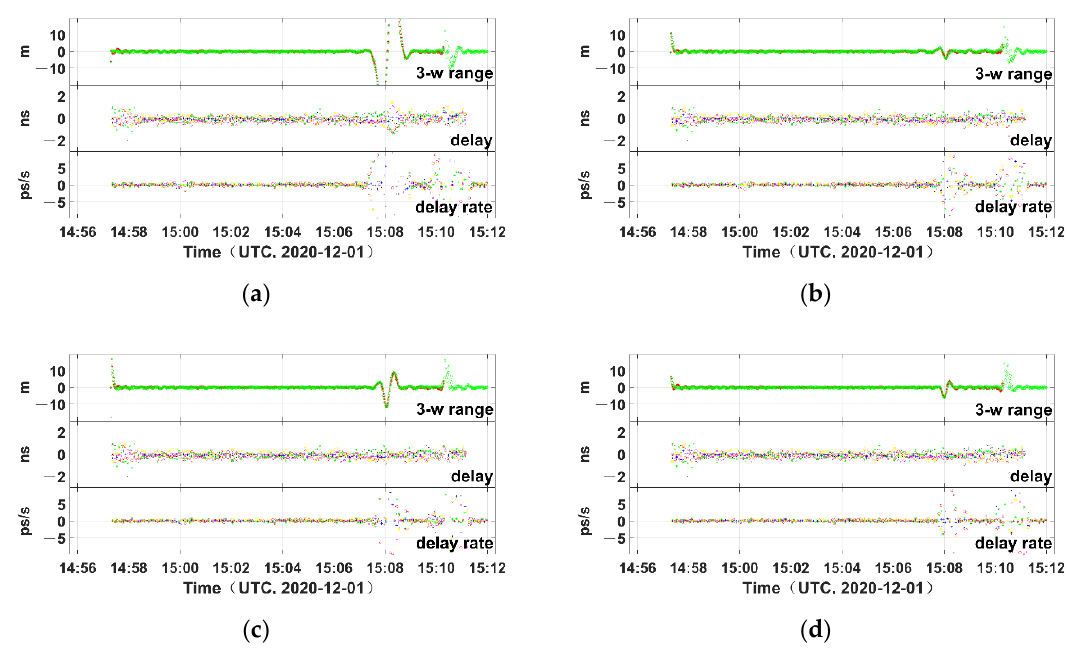
Figure 1. Residual plots by selecting different nodes in the method based on B-spline function during decent: ( a ) 30 nodes were selected; ( b ) 40 nodes were selected; ( c ) 50 nodes were selected; ( d ) 60 nodes were selected.